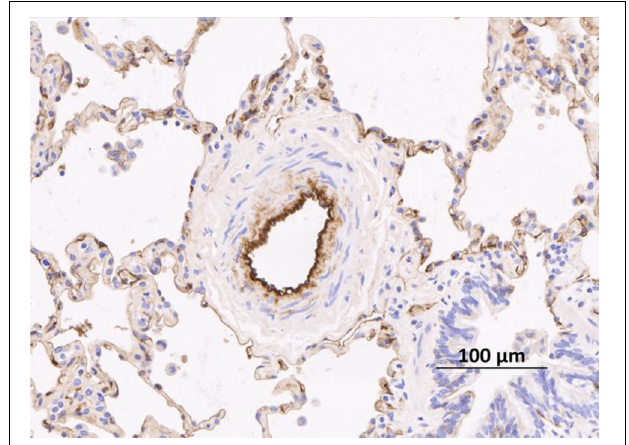
FIGURE 3 | Remodeled pulmonary arteriole from a patient with idiopathic pulmonary arterial hypertension taken after transplant. Remodeling in this case is characterized by an increase in the number of smooth muscle cells in the media. The endothelium is stained with an anti-vWF antibody (brown stain). vWF, von Willibrand Factor. Figure courtesy of Dr. Allan Lawrie and Dr. Roger Thompson, University of Sheffield, United